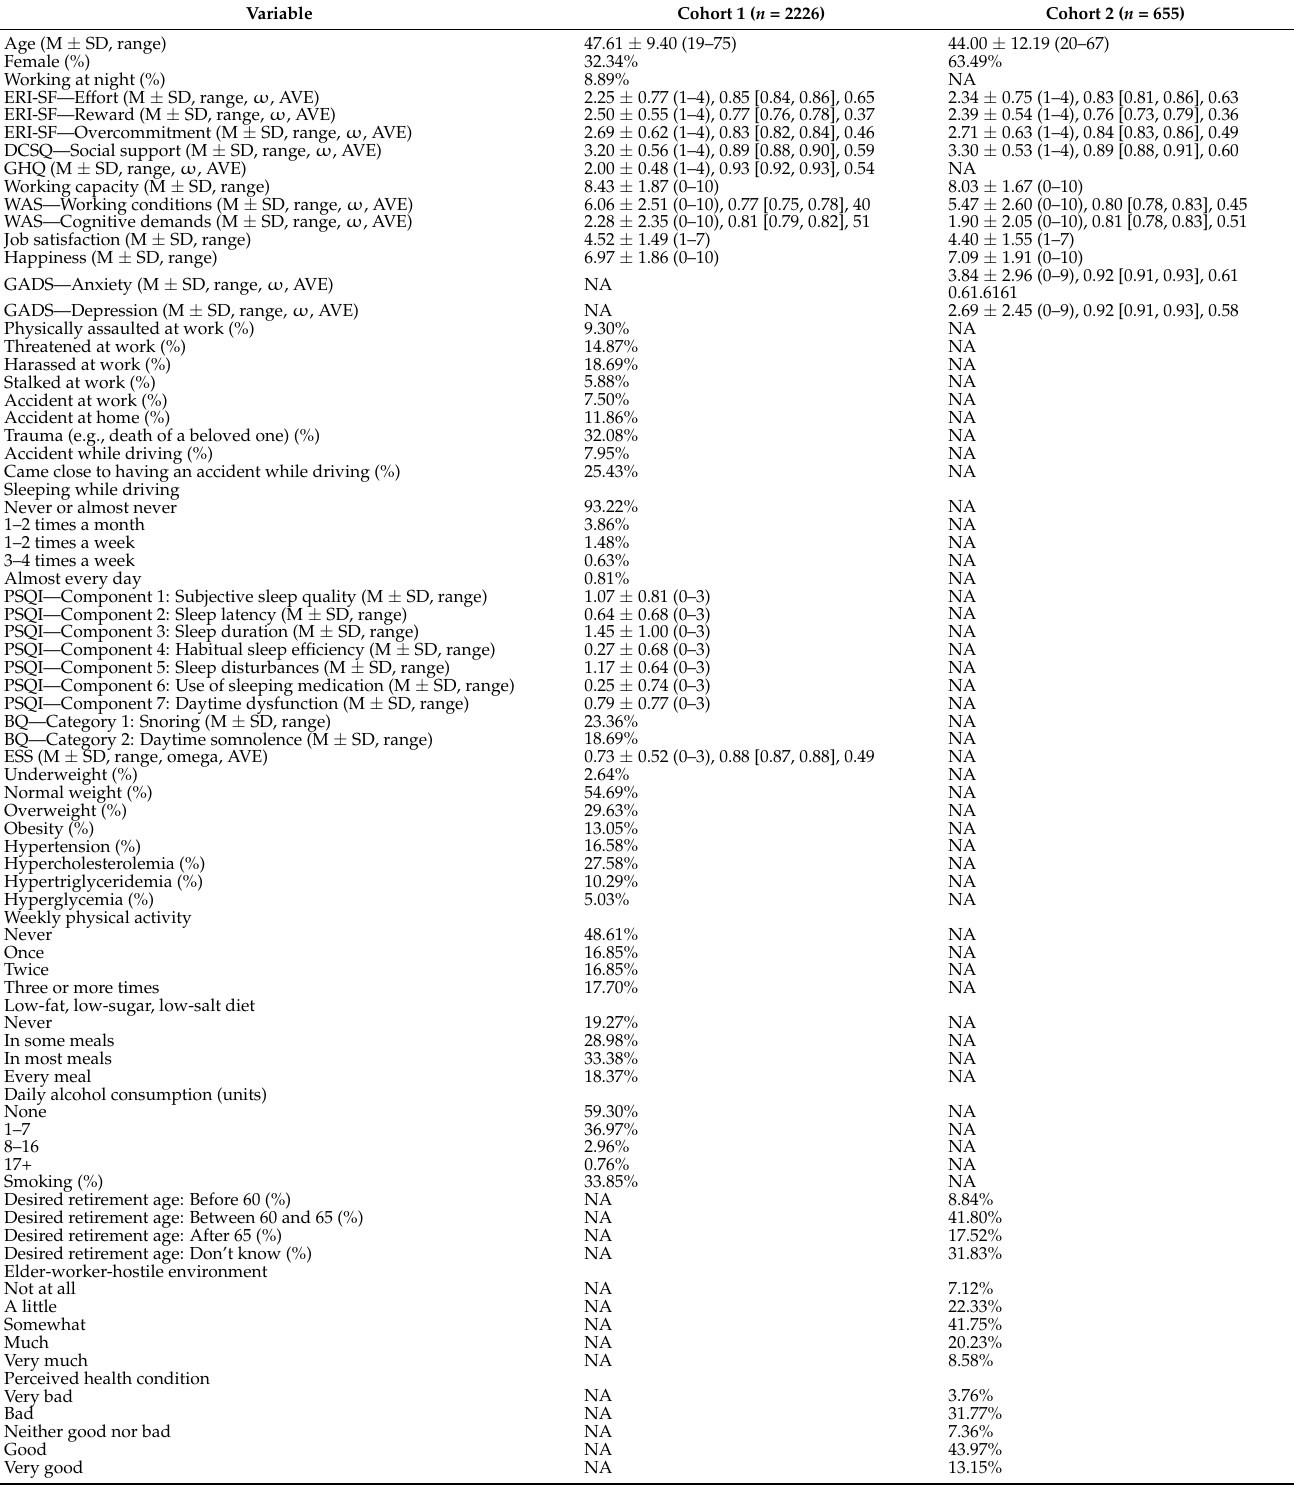
Table 1. Descriptive statistics of the variables used in this work (1/2)